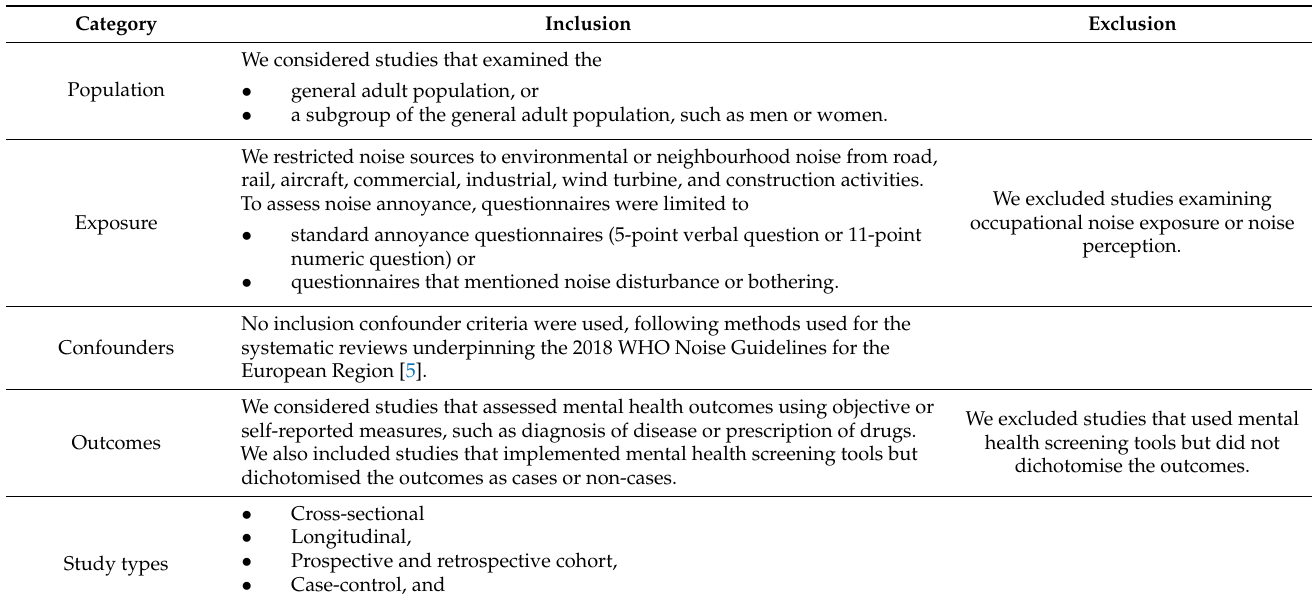
Table 1. PECCOS review inclusion and exclusion